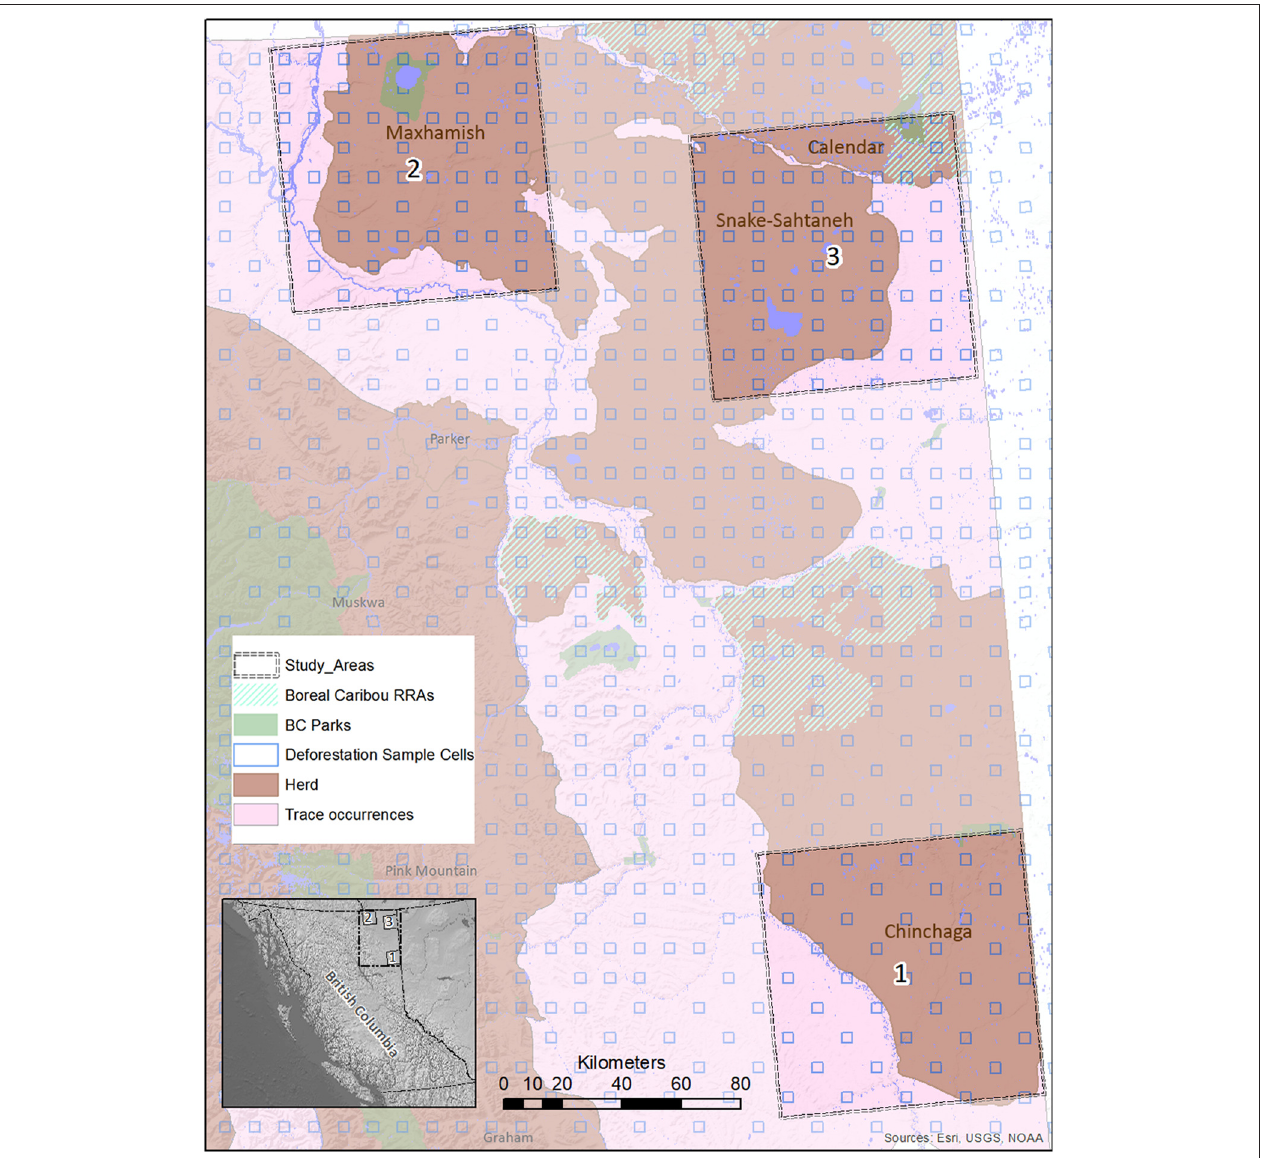
FIGURE 2 | A map of study areas in Northeastern B.C. selected for use in the BRAT (LOPA) analysis, showing their relationship to caribou herds, protected areas, and deforestation sample cells. The location of the study areas within the entire province is also shown (inset, lower